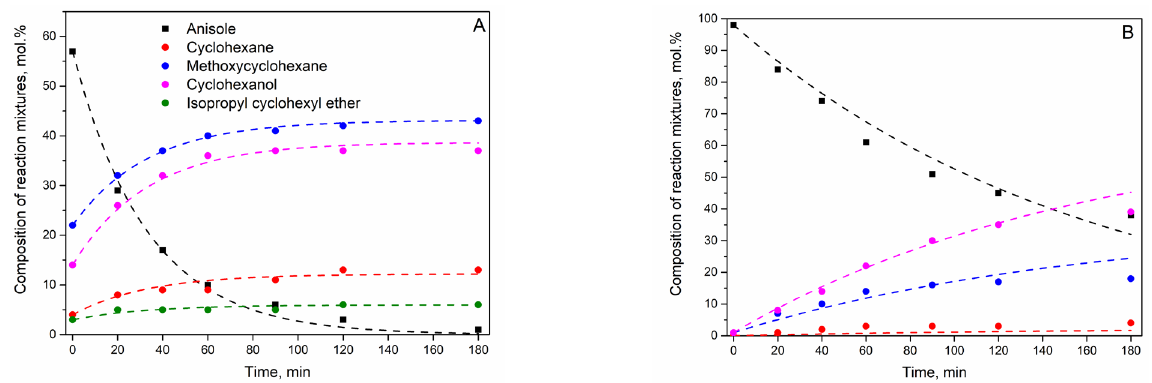
Figure 4. Percentage composition of the reaction mixtures as a function of time obtained over Ni(36)–SiO 2 at ( A ) 250 °C, 7.3–8.1 MPa, and ( B ) 150 °C, 0.8–1.0 MPa; m(catalyst) = 0.10–0.11 g at 250 °C and 0.36–0.37 g at 150 °C. The dots present the experimental data, and the lines were calculated using a quasi-first-order kinetic model.